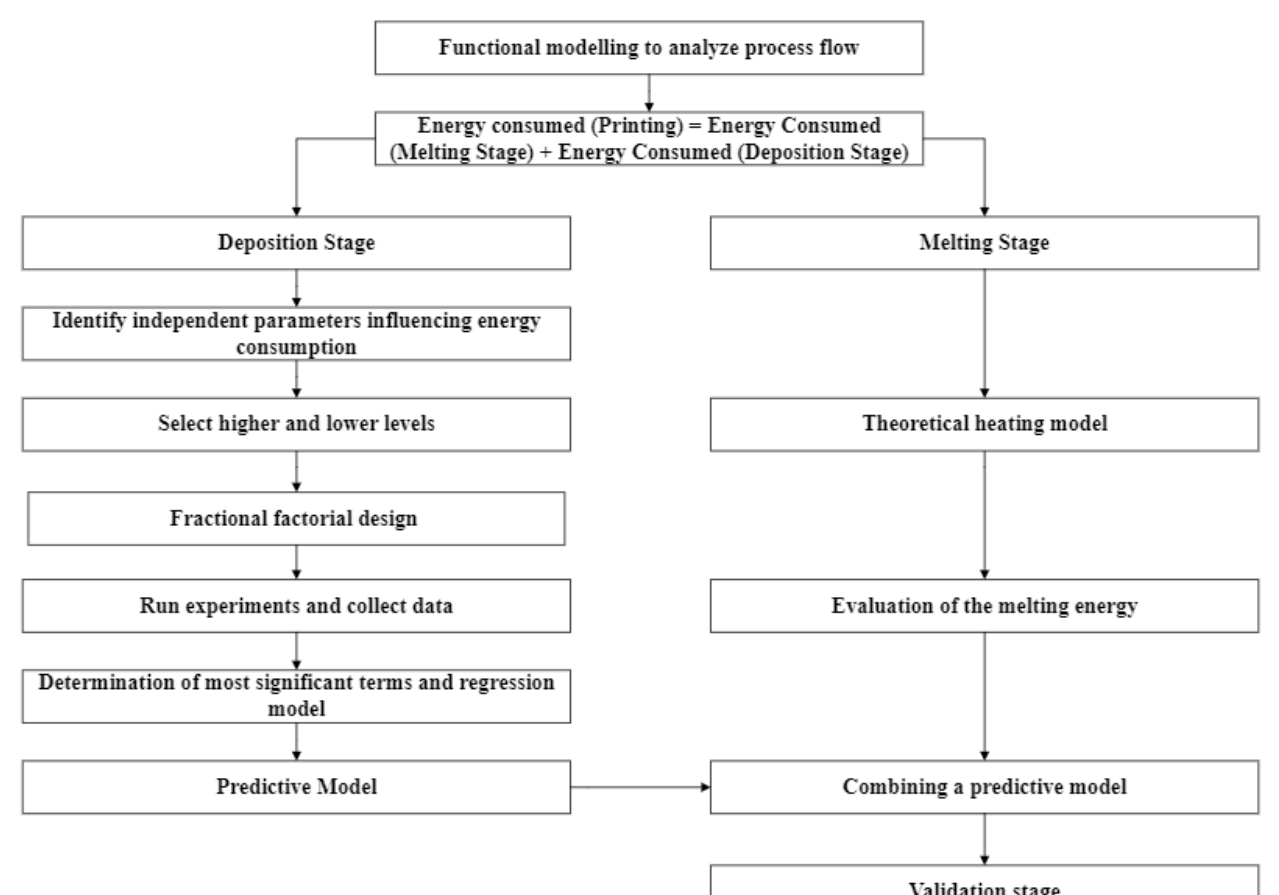
Figure 1. The proposed framework for developing a predictive energy consumption model of 3DP- CFRP.